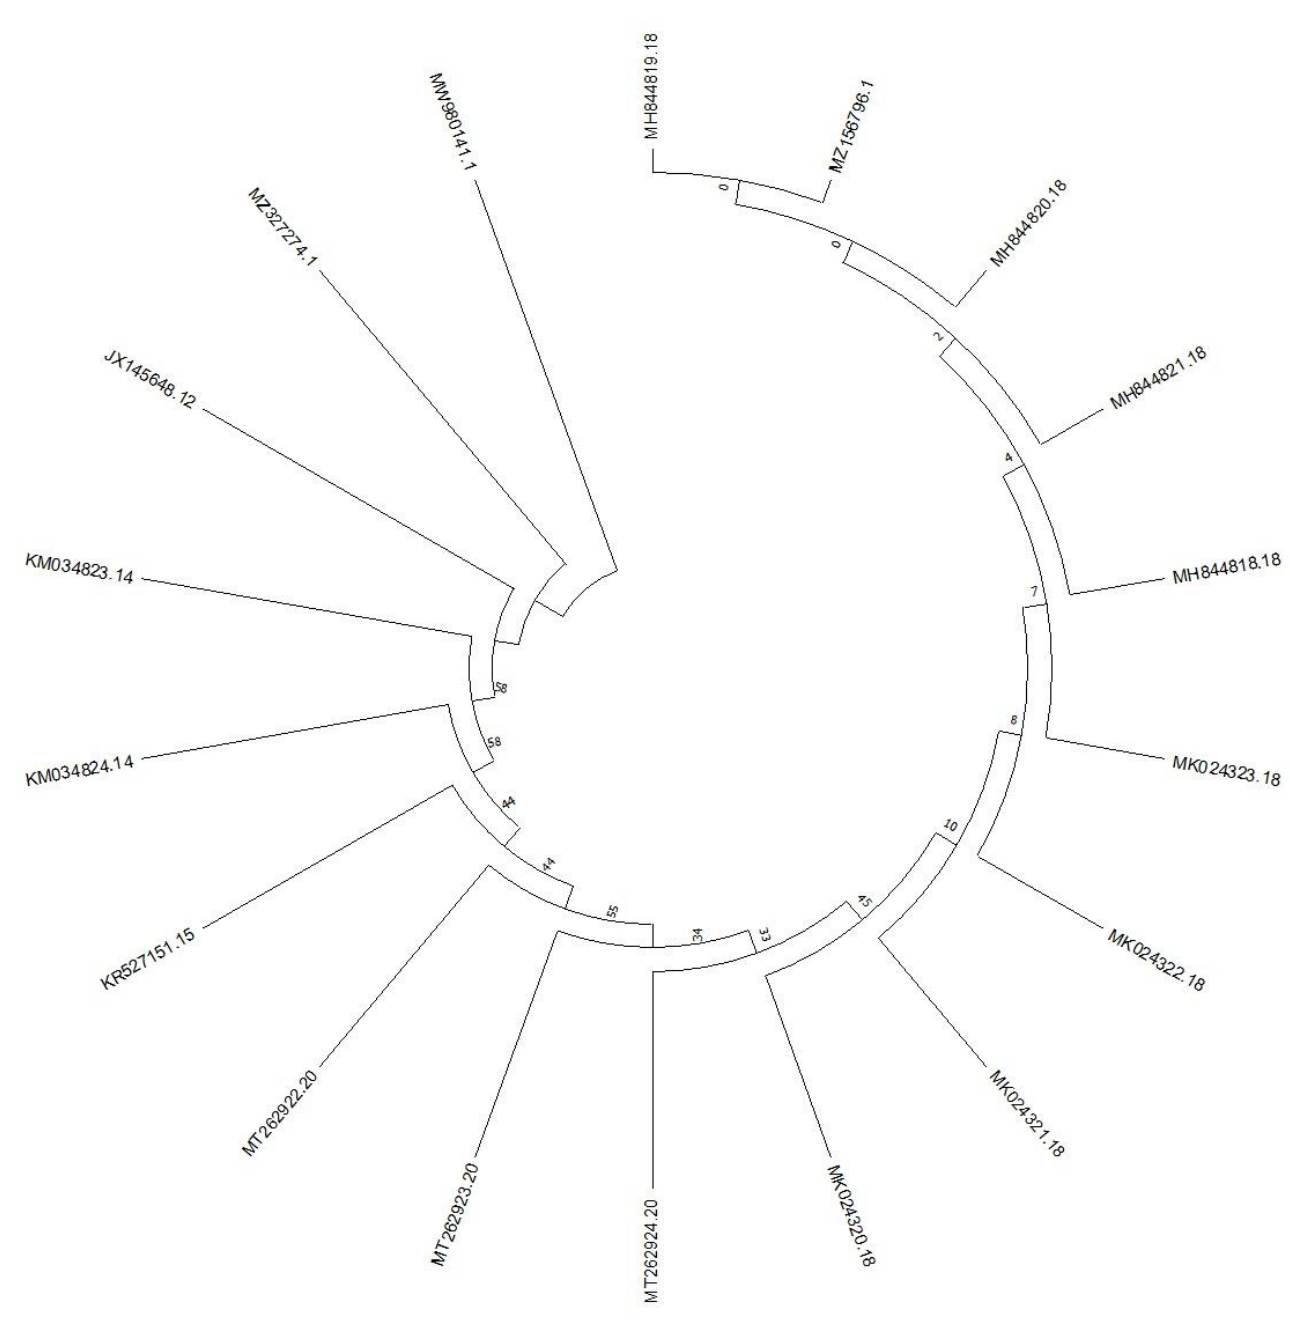
Figure 1. Phylogenetic analysis of ( a ) ITS, ( b ) TEF- 1α , and ( c ) GAPDH nucleotide sequences of B. sorokiniana.